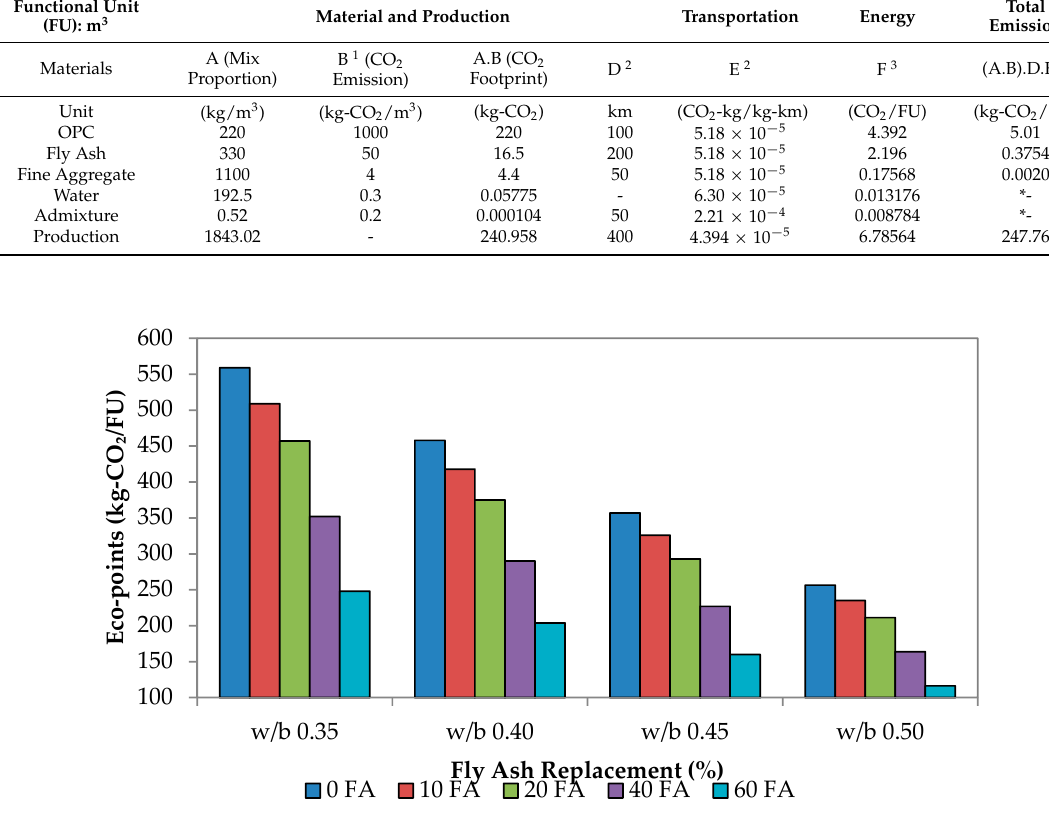
Figure 20. Eco-points of self-compacting mixes.